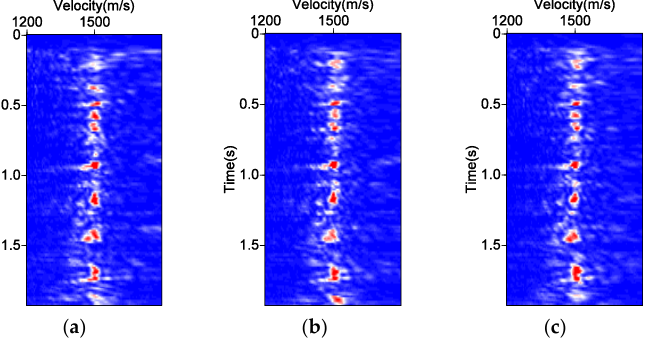
Figure 2. Similarity of adjacent velocity spectra. ( a ) Velocity spectrum of CD P32; ( b ) velocity spectrum of CDP 34; ( c ) velocity spectrum of CDP 36.